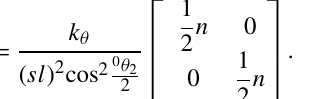
Figure 24. Docking diagram.